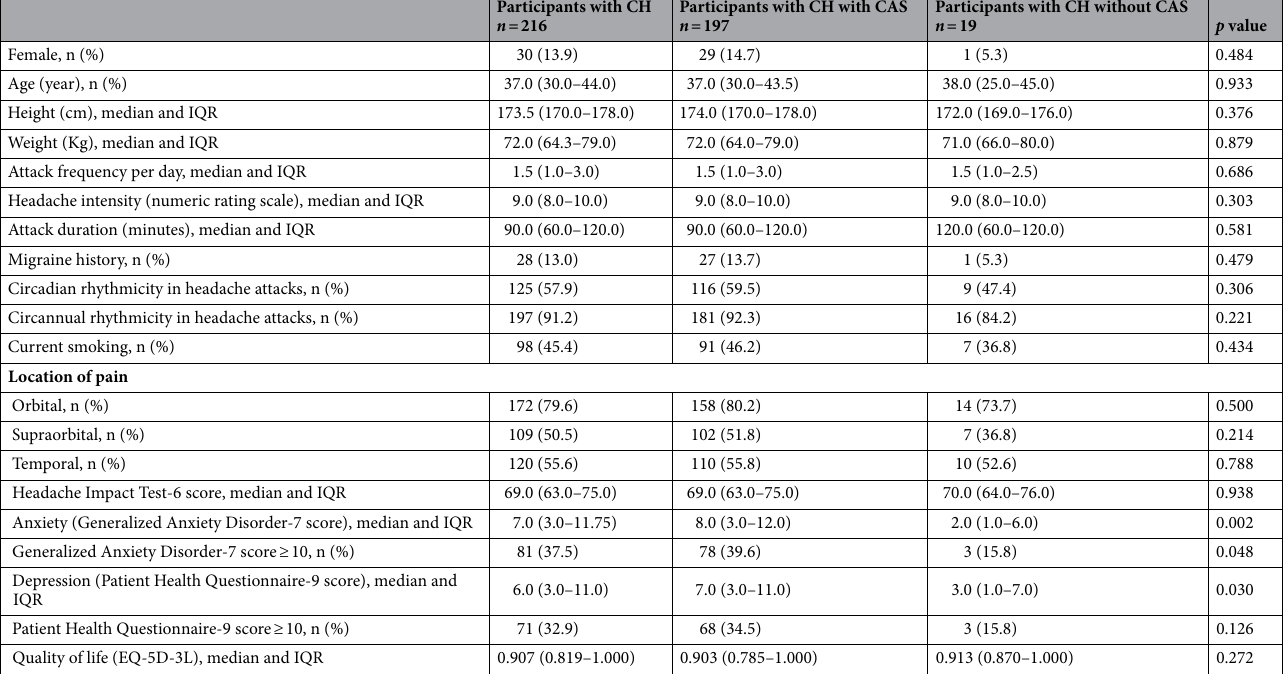
Table 3. Clinical features of participants with CH according to the presence of CAS. CAS cranial autonomic symptoms, CH cluster headache, EQ-5D-3L the 3-level version of EuroQol five-dimension scale, IQR interquartile